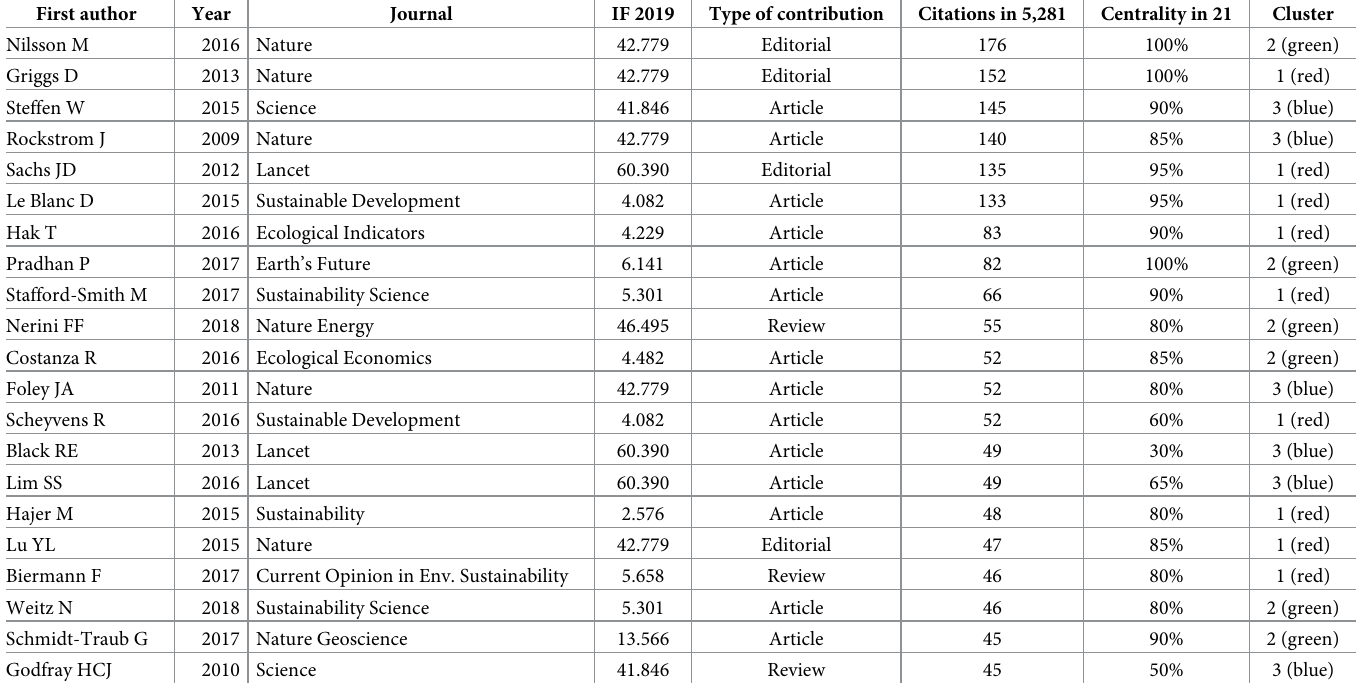
Table 8. Articles cocited as references in the set of articles studied.